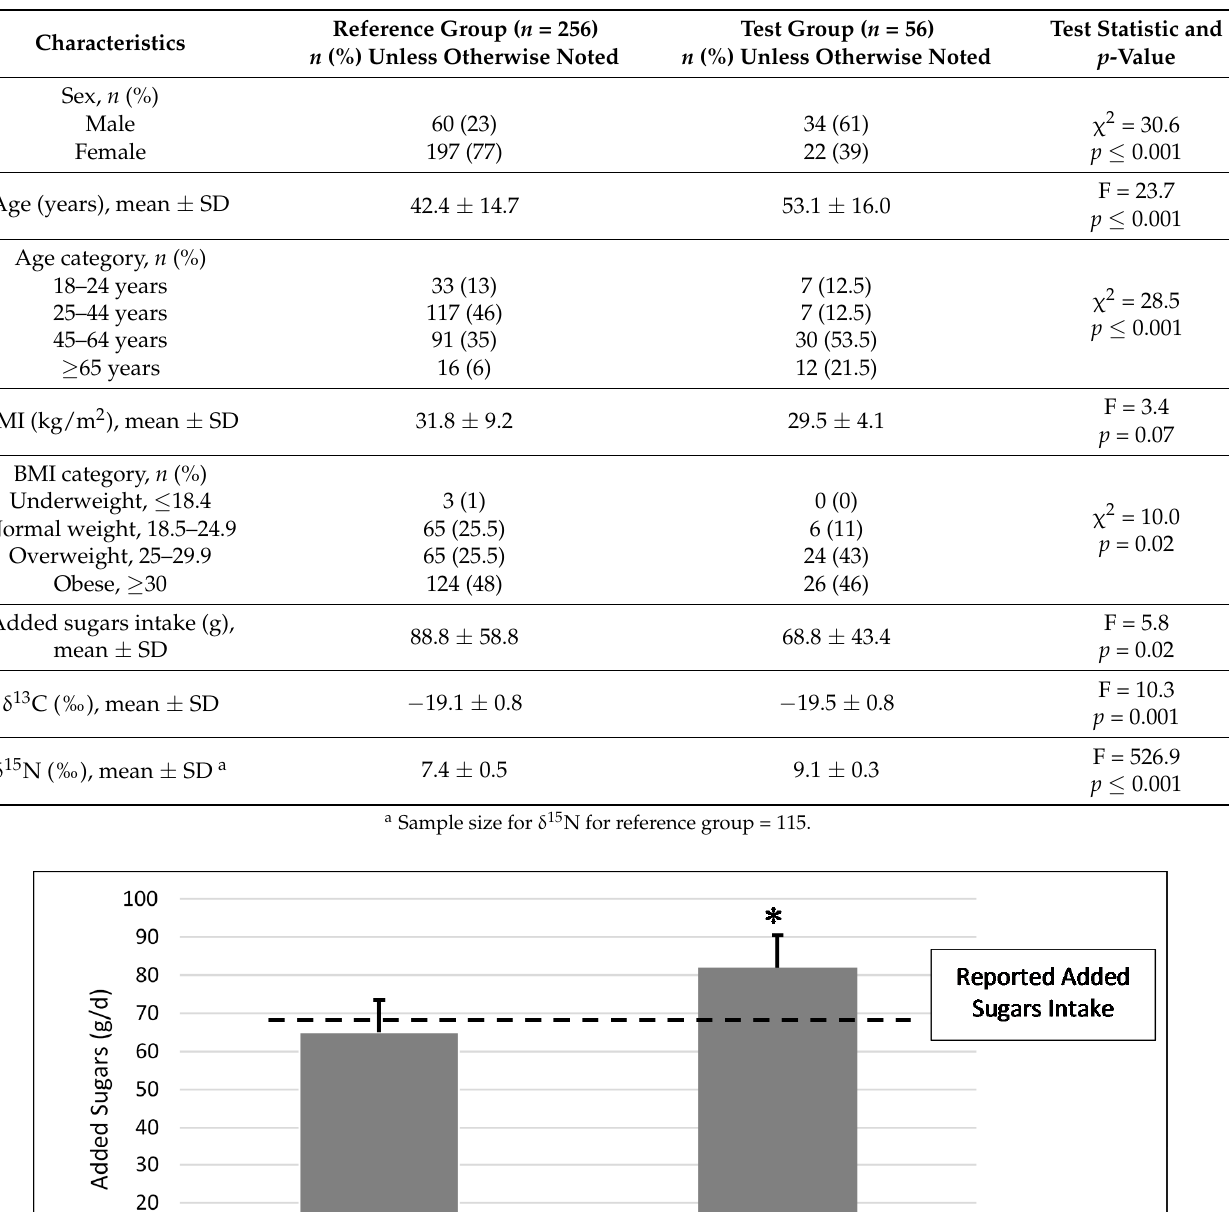
Table 1. Differences in participant demographics between the reference and test groups.